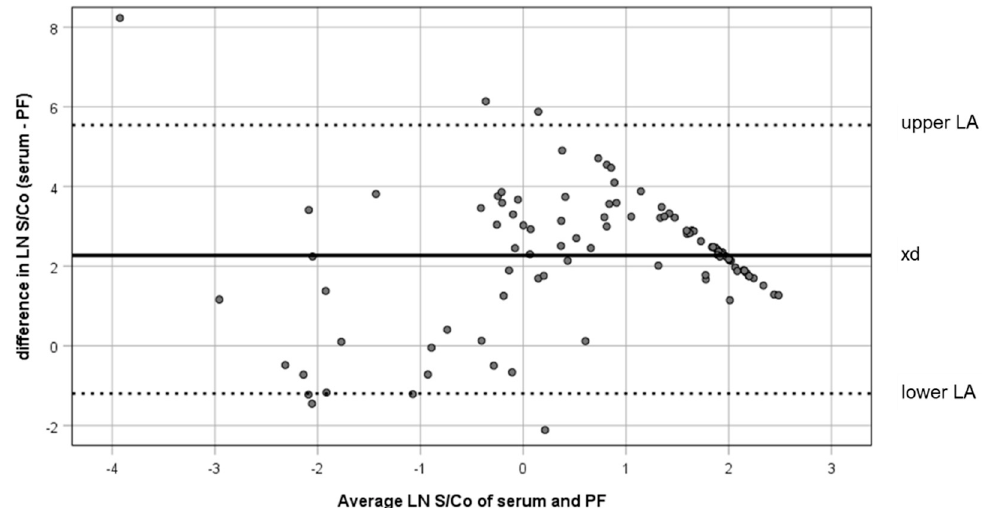
Figure 2. Individual sample comparisons of serum and processing fluid (PF) results: The difference in ELISA S/Co (serum S/Co – PF S/Co) was plotted against the mean S/Co of serum and PF. The mean of difference (xd) and limits of agreement (LA) are marked.